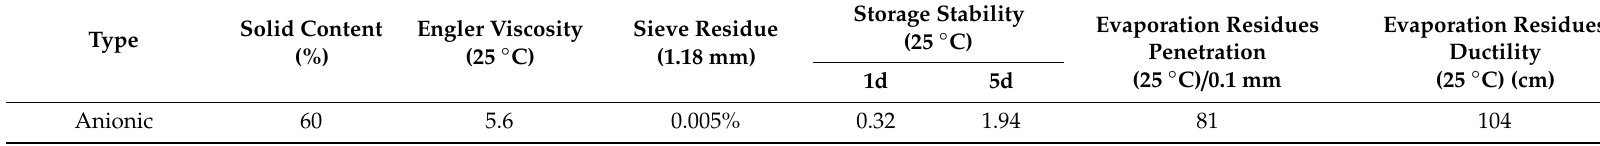
Table 1. Physical properties of emulsified asphalt.